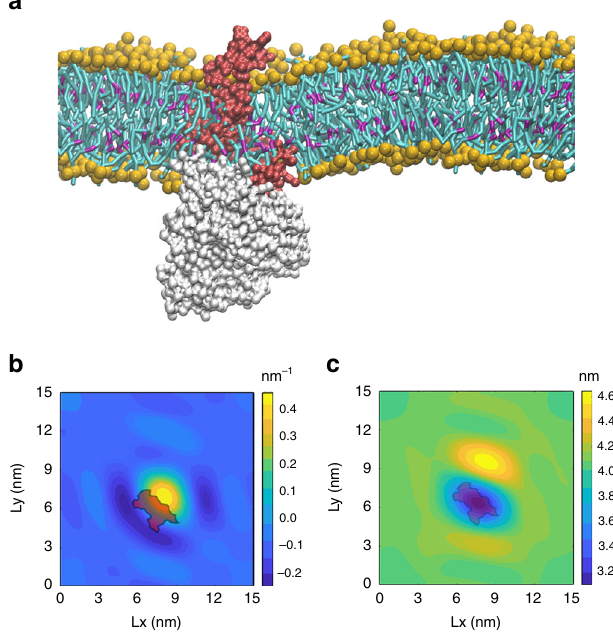
Fig. 3 ECF-FolT2 induced membrane deformation. a MD snapshot showing the local membrane bending around the ECF module. EcfT is colored in red, EcfA and EcfA ′ in white, and the phosphate groups of the lipids are colored in orange. Lipid tails are depicted in cyan with magenta for the unsaturated parts. b Curvature map around the ECF module (outline) for the upper lea fl et, Lx and Ly denote bilayer lateral directions. c Membrane thickness map around the ECF module.